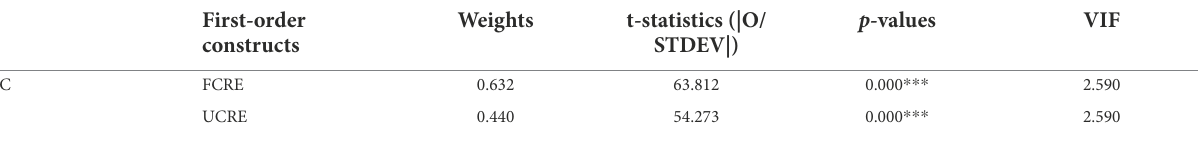
TABLE 8 Formative indicators weights, significance and test of multi-collinearity.